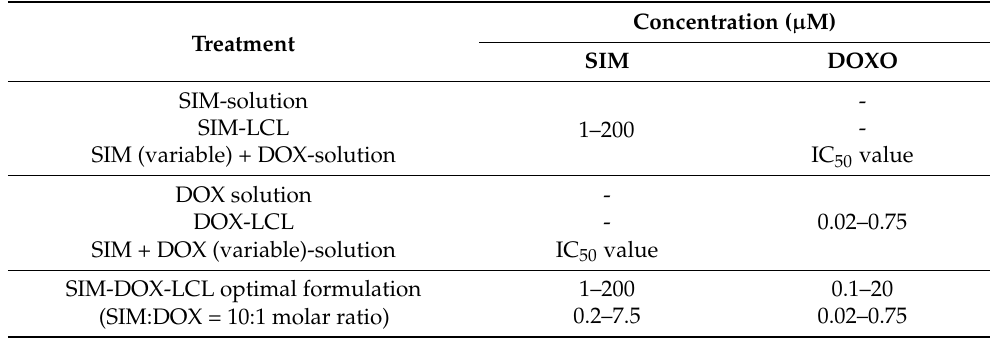
Table 7. The pharmaceutical formulations and the concentrations used for SIM and DOX in the antiproliferative